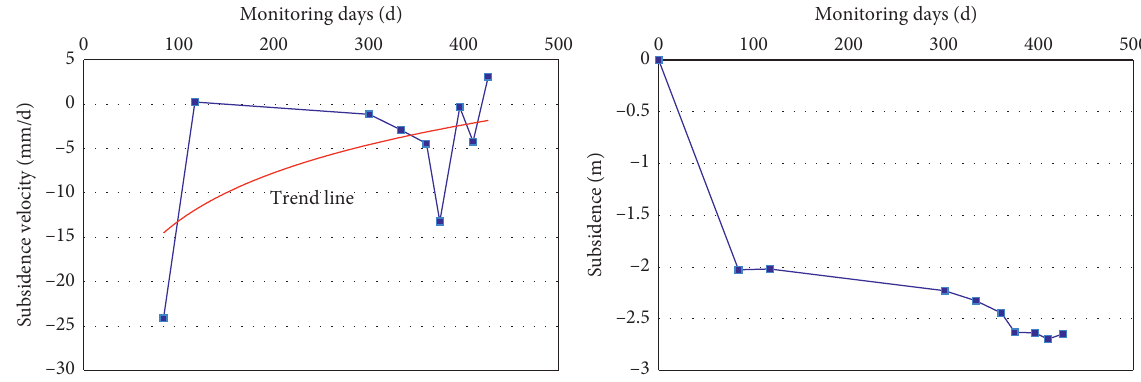
Figure 14: The subsidence velocities and magnitude with respect to time.